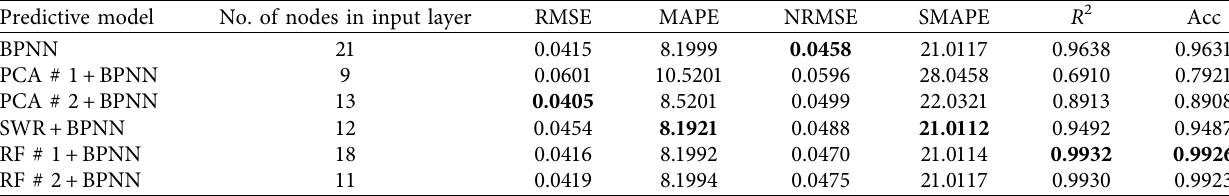
Table 6: Performance of proposed predictive models on the test sample.